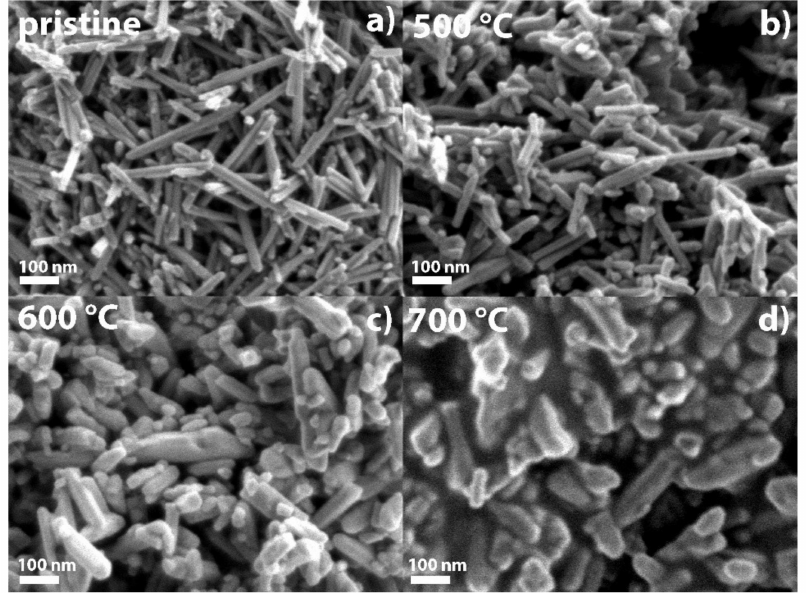
Figure 8. SEM images of ZnO-(Q)NRs ( a ) pristine and after use in time on stream (TOS) reactions